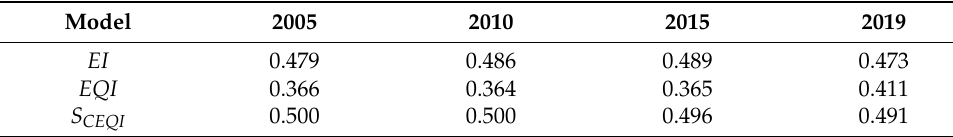
Table 5. Annual ecological environmental quality index of EI , EQI , and S CEQI .